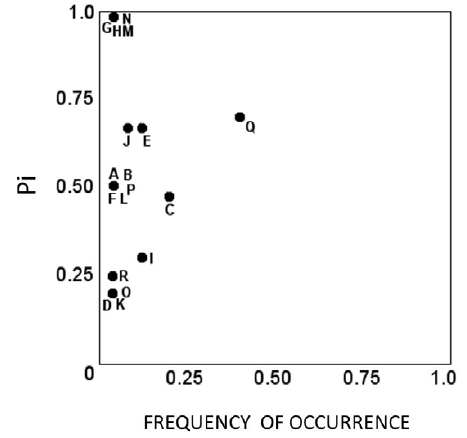
Figure 2 - Specialization diagram of Haddadus binotatus population from an Atlantic Rainforest area in the state of Rio de Janeiro, southeastern Brazil. The Y axis (Pi) shows the proportion of the prey item only for the individuals that consume it. The X axis shows the frequency of occurrence of the prey items in the diet. Each letter inside the diagram represents one prey type (A = Acari; B = Araneae; C = Blattodea; D = Chilopoda; E = Coleoptera; F = Dermaptera; G = Diplopoda; H = Diptera; I = Hymenoptera (Formicidae); J = Hemiptera; K = Homoptera; L = Isopoda; M = Isoptera; N = Lepidoptera; O = Mantodea; P = Opiliones; Q = Orthoptera; R = Scorpiones).